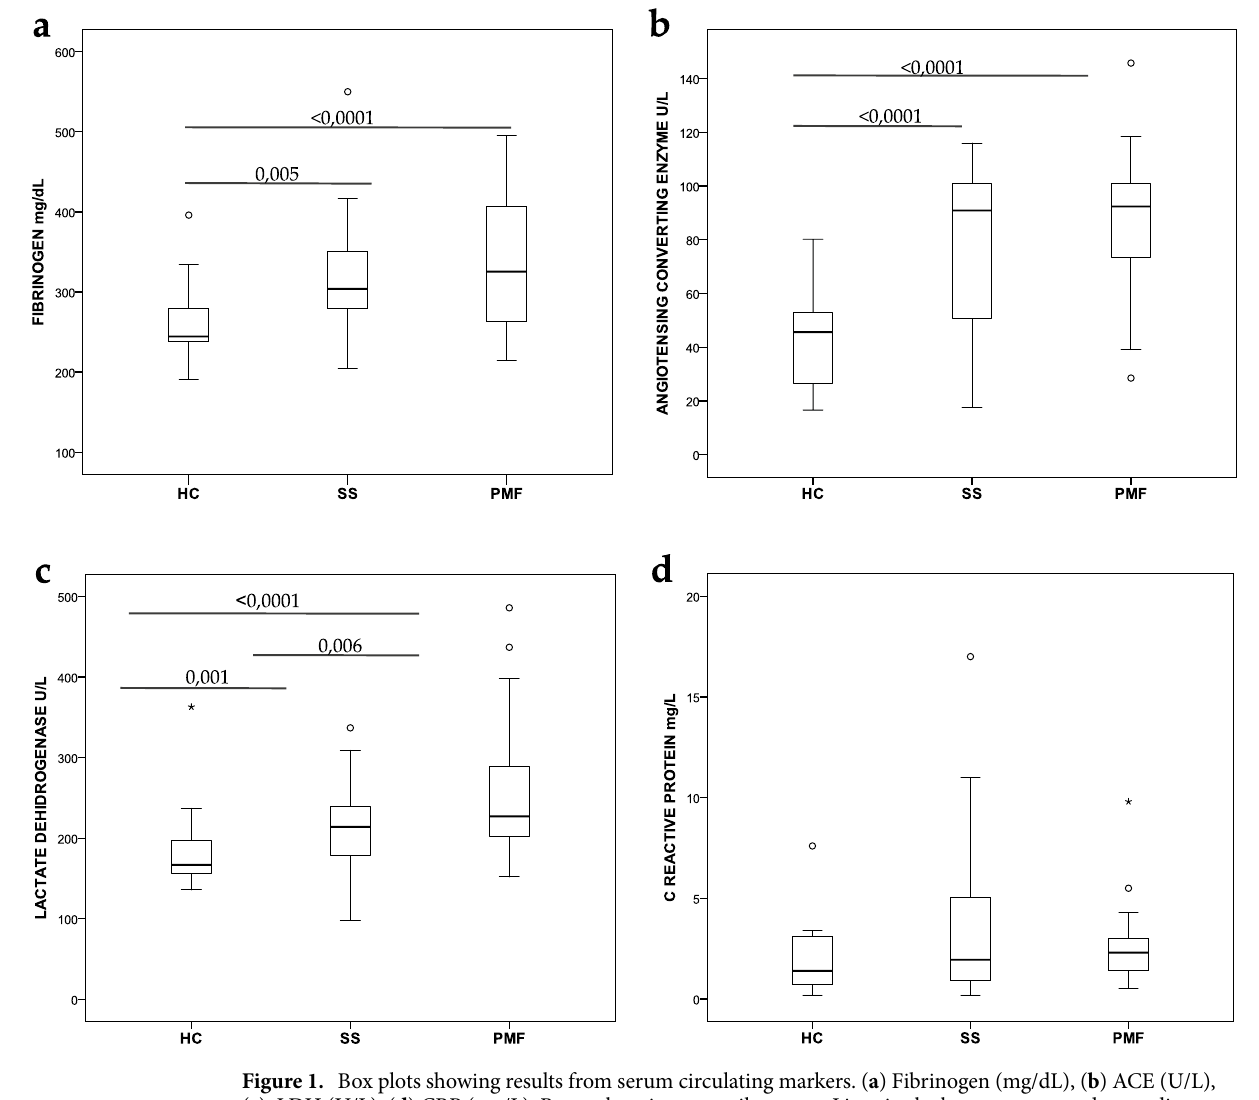
Figure 1. Box plots showing results from serum circulating markers. ( a ) Fibrinogen (mg/dL), ( b ) ACE (U/L), ( c ). LDH (U/L), ( d ) CRP (mg/L). Boxes show interquartile ranges. Lines in the boxes correspond to medians, and bars represent the lowest and highest values. Circles represent outliers. Student’s t-test in ( a ) and the Mann– Whitney U -test in ( b – d ) were applied. p values with significant differences between groups are indicated by horizontal